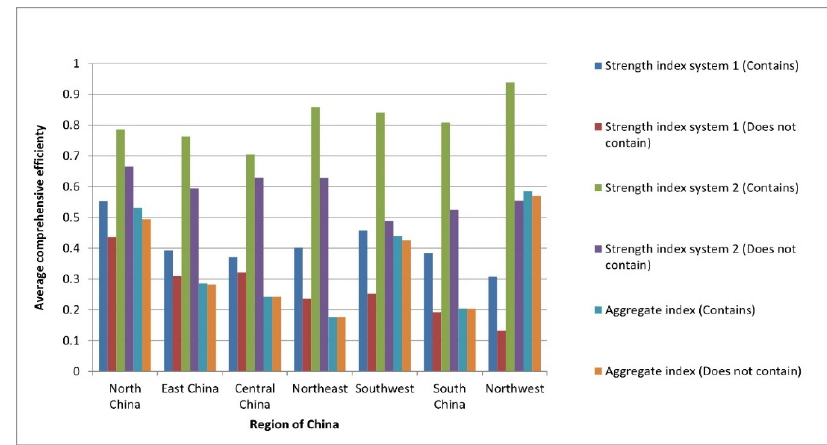
Figure 2. Average comprehensive efficiency of each region.